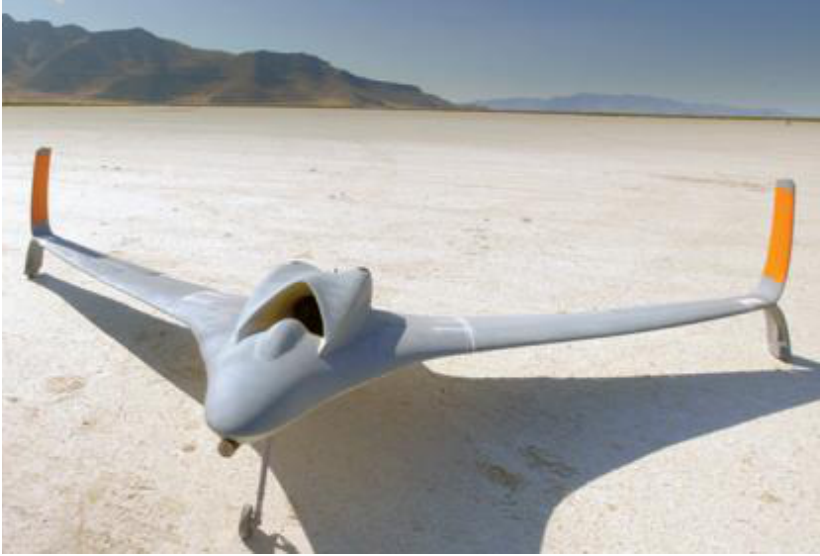
Figure 16. UAV using the FDM process. Adapted with permission from Stratasys [202].